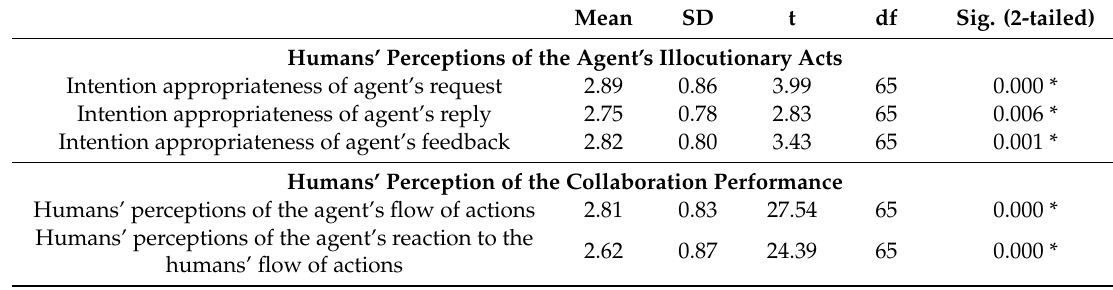
* Significance at the 0.01